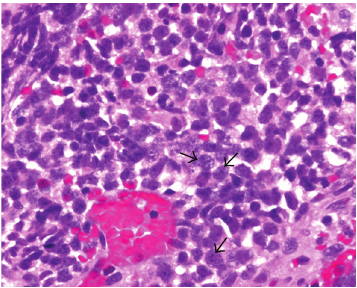
Figure 4: The tumor cells (see arrows) exhibit features of small- cell carcinoma: nuclear molding, high nuclear-to-cytoplasm ratio, and fine chromatin pattern/“salt and pepper” nuclei. H and E (hematoxylin and eosin)